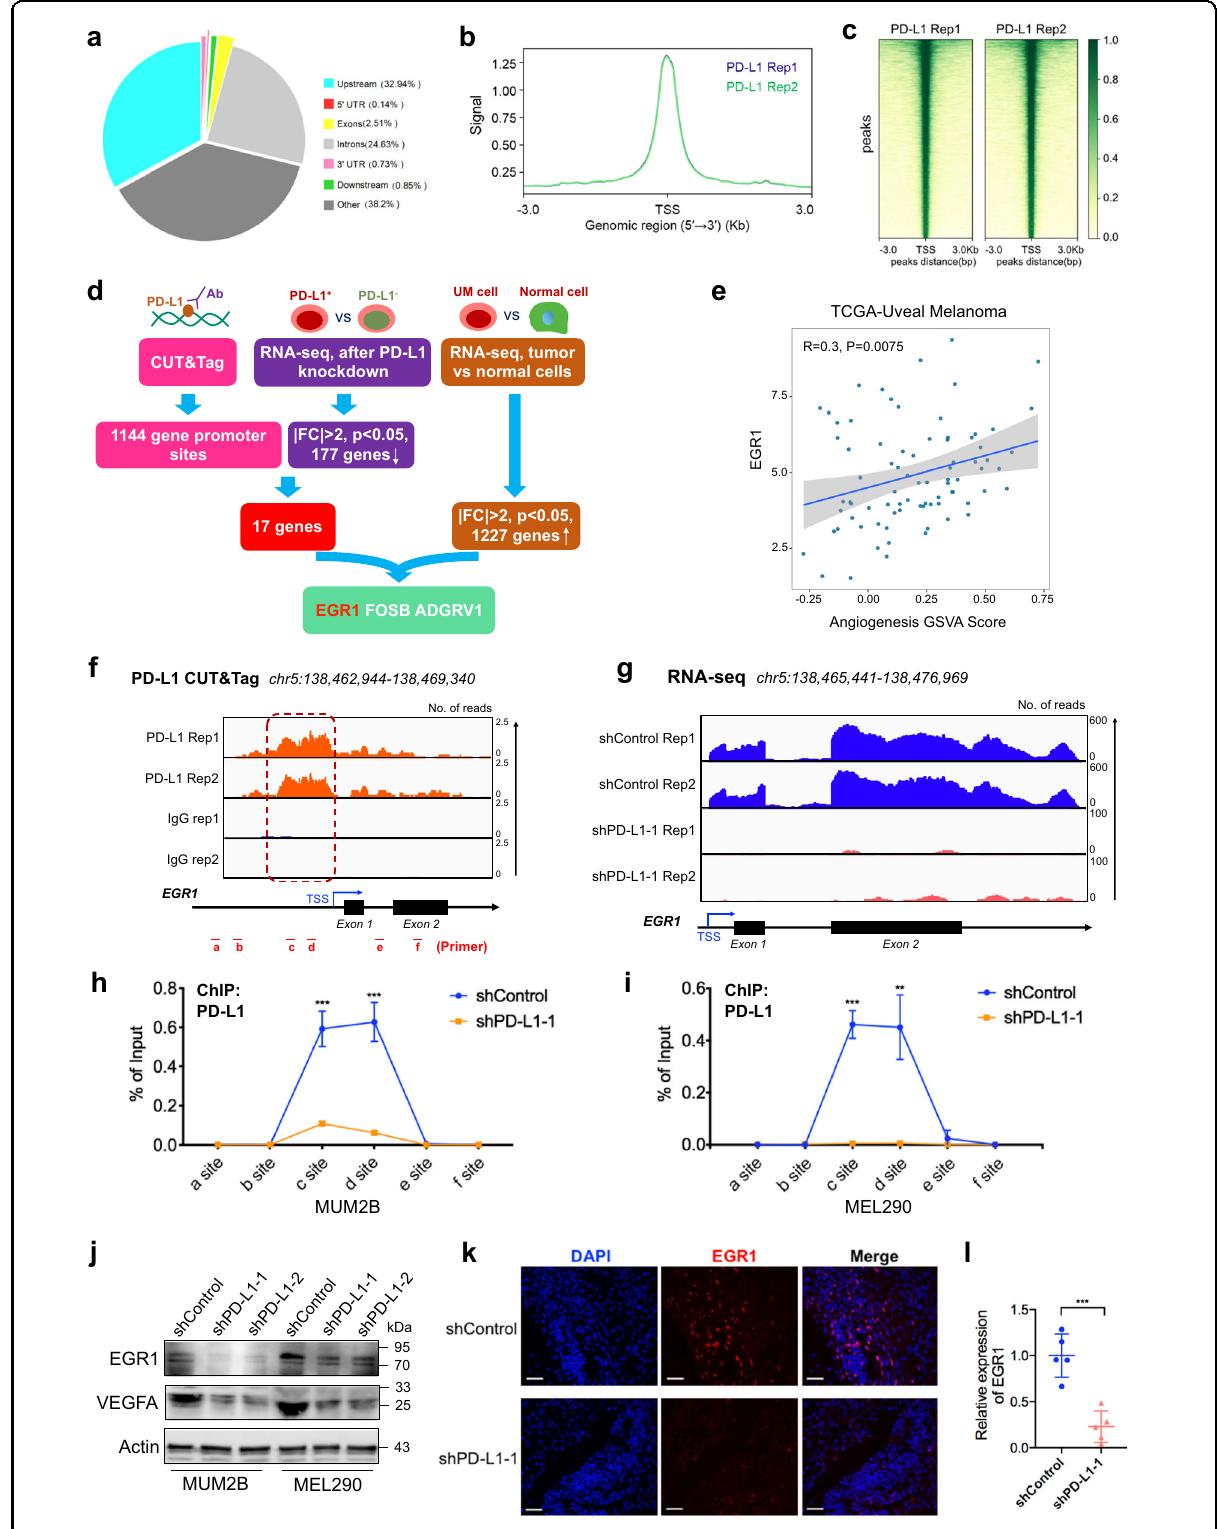
Fig. 3 (See legend on next